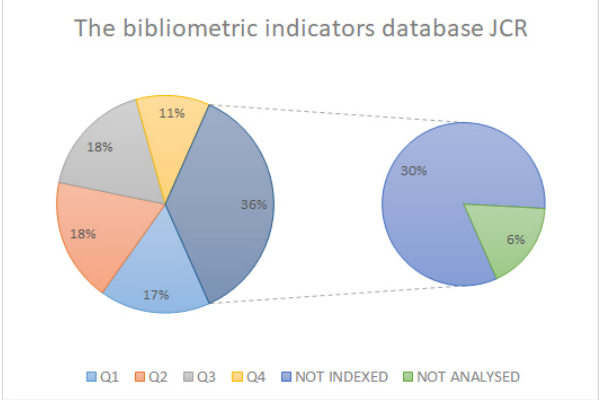
Figure 3. JCR database bibliometric indicators.